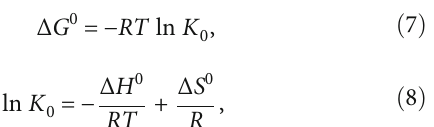
O nanoparticles and MOF/NH 3 4